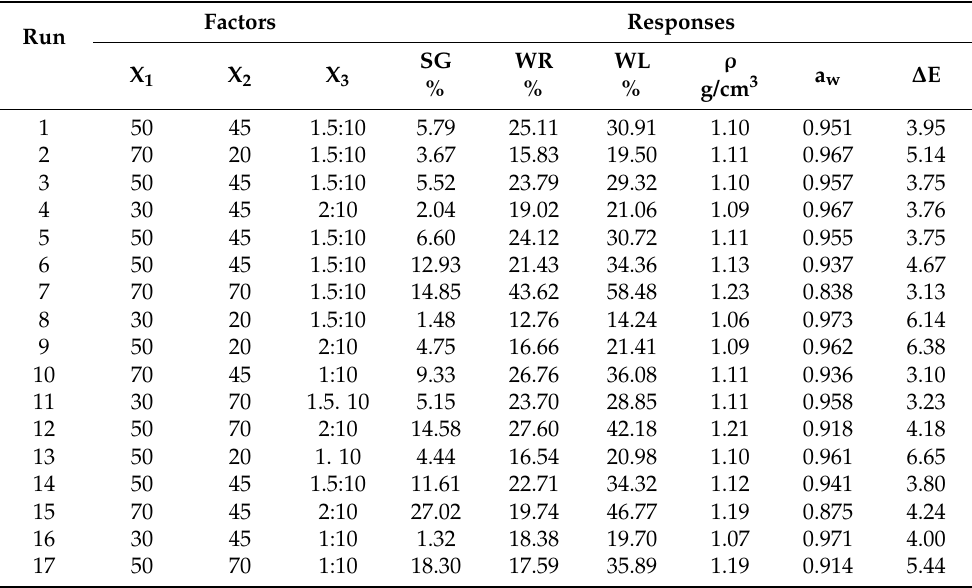
Table 2. Uncoded Box–Behnken design independent variables and experimental data of ob- served